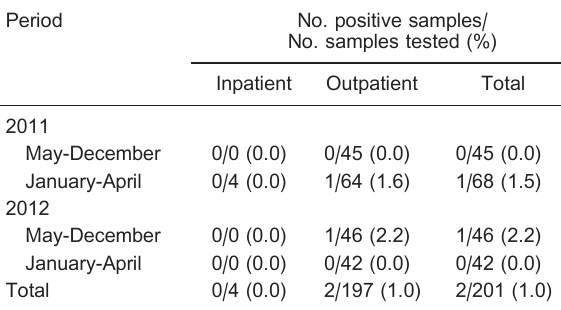
Table 2. Distribution of acute diarrhea and rotavirus-related cases in hospitalized patients and outpatients from Uberlaˆ ndia during rotavirus season (May to December) and non-rotavirus season (January to April),